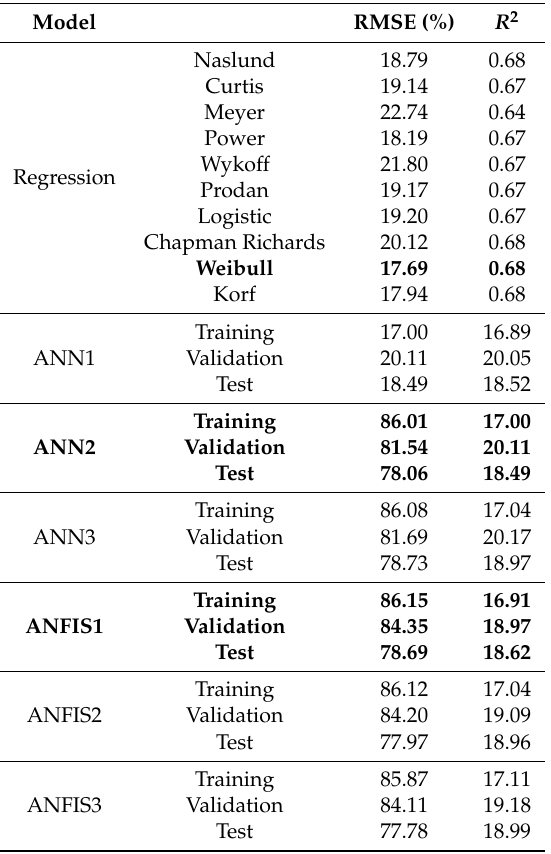
Table 8. Validation results of the regression, ANN, and ANFIS